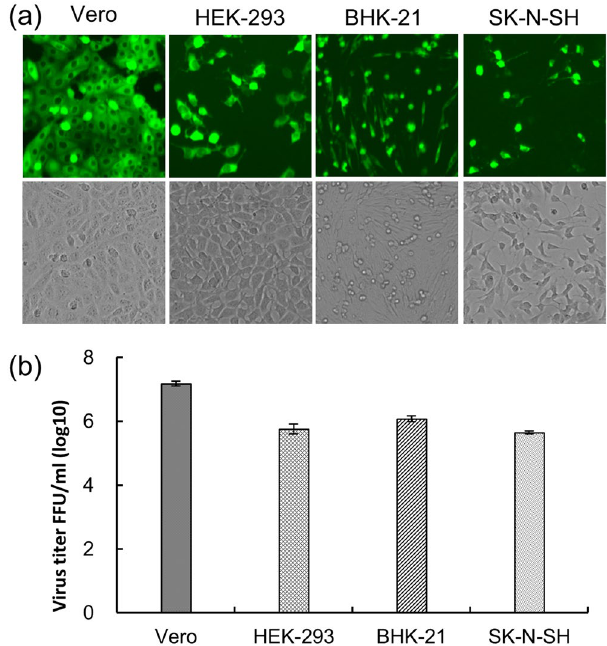
Figure 4. Infectious properties of WNV RRPs in Vero, HEK-293, BHK-21 and SK-N-SH cells. ( a ) Expression of the GFP reporter gene in each cell line after the infection of equal amounts of RRPs. ( b ) Monolayers of each cell line in a six-well plate containing 10 5 to 10 6 cells/well were infected in parallel with 10-fold serial dilutions of WNV RRPs. Cells positive for GFP protein were counted at the appropriate dilution and the number of RRPs per 1 mL of supernatant were calculated.